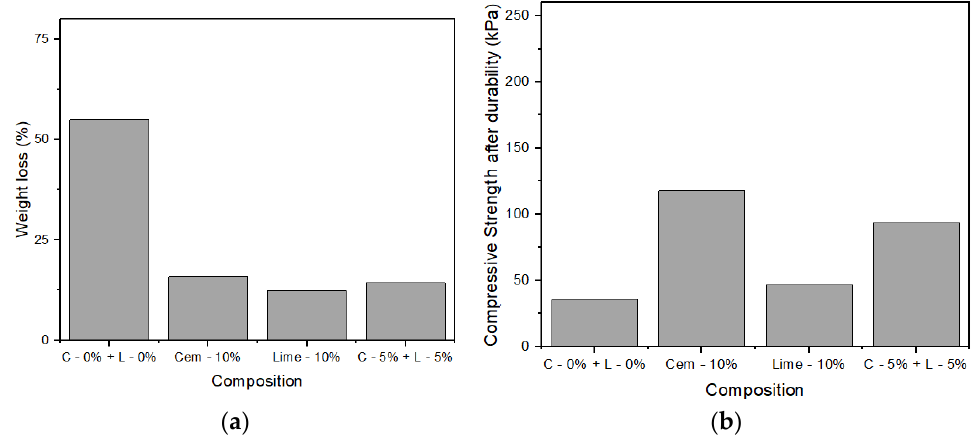
Figure 11. Durability results for the adobe blocks with manure: ( a ) mass loss; ( b ) compressive strength.